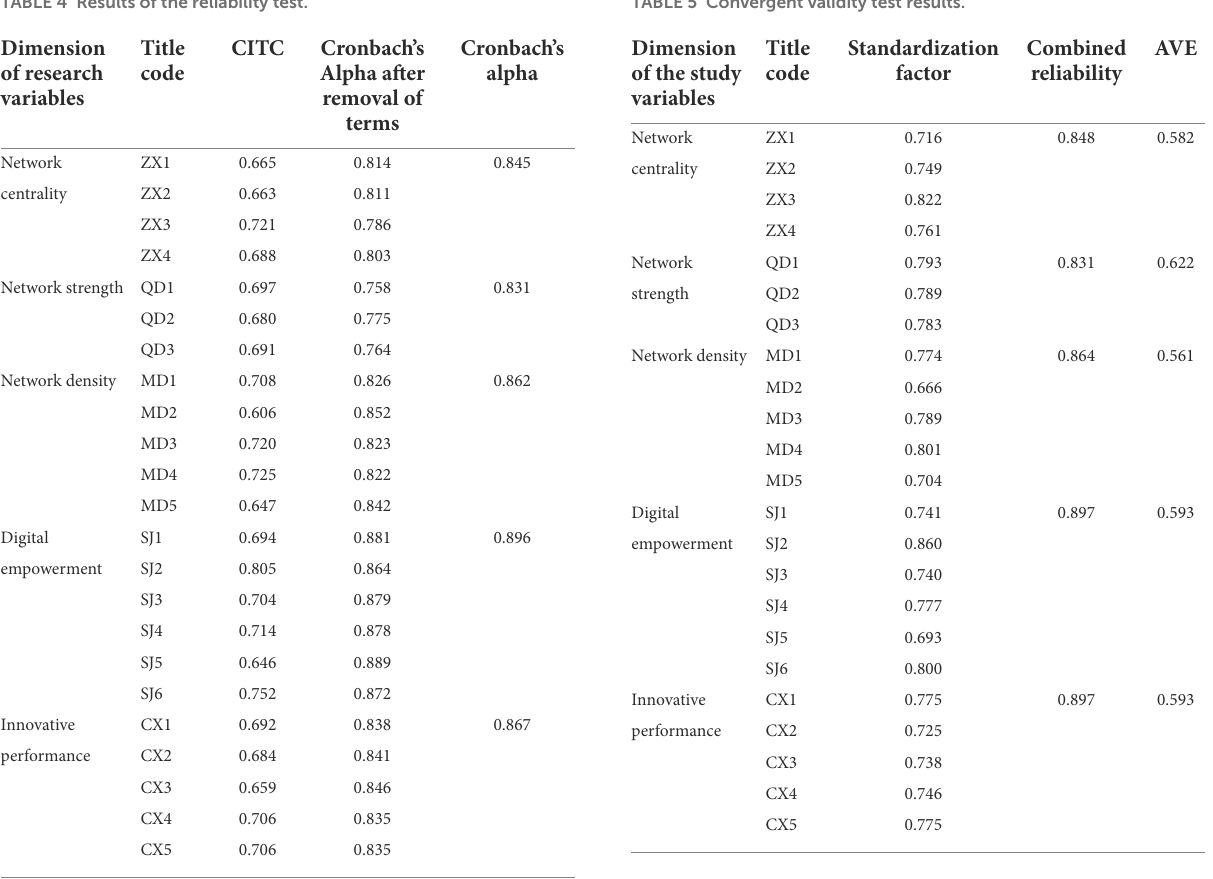
TABLE 4 Results of the reliability test. TABLE 5 Convergent validity test